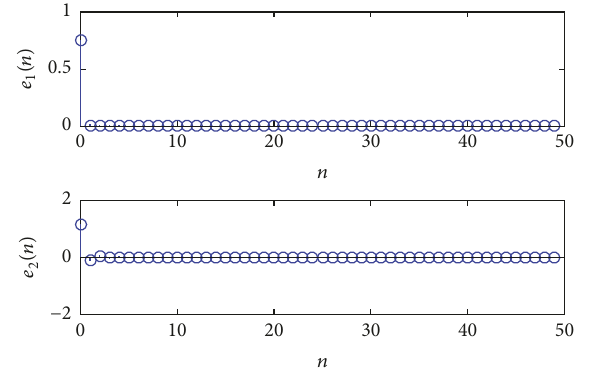
Figure 4: The evolution of errors over time for Case